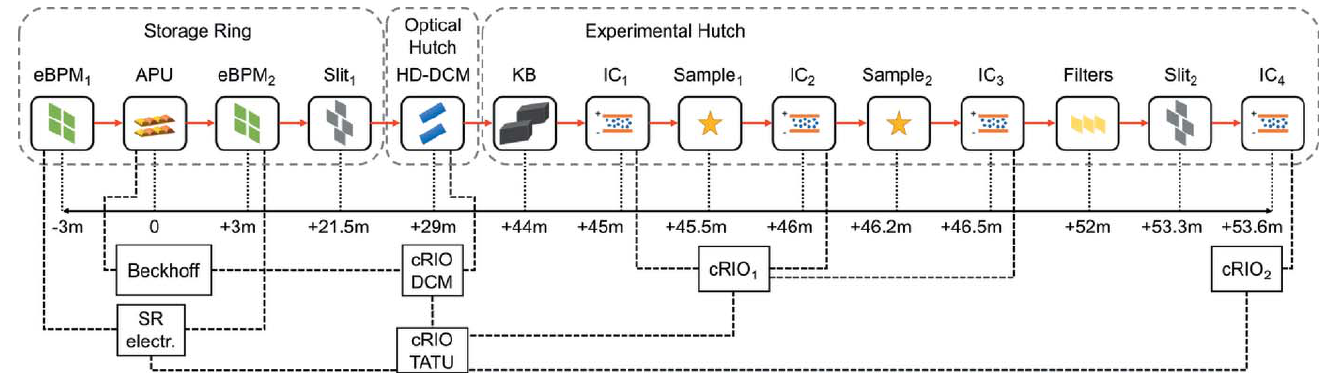
Figure 8 Simplified EMA beamline setup for the experiments with the HD-DCM, including: the APU22 source, electron beam position monitors (eBPMs); high- heat-load slits (Slit 1 ); the HD-DCM; focusing Kirkpatrick–Baez (KB) mirrors; ionization chambers (IC 1 , IC 2 , IC 3 and IC 4 ); sample stages (Sample 1 and Sample 2 ); metal filters and monochromatic slits (Slit 2 ). Connections among the Beckhoff’s motion controller for the APU22, storage ring (SR) electronics for the eBPMs, and NI’s cRIOs used as controller (HD-DCM), data acquisition hardware (ICs) and trigger unit (TATU) are also indicated. More details are provided in the text. Distances with respect to the undulator are provided for general